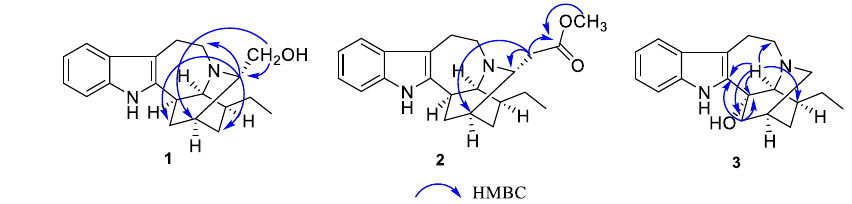
Fig. 2 Key HMBC correlations of compounds 1 –